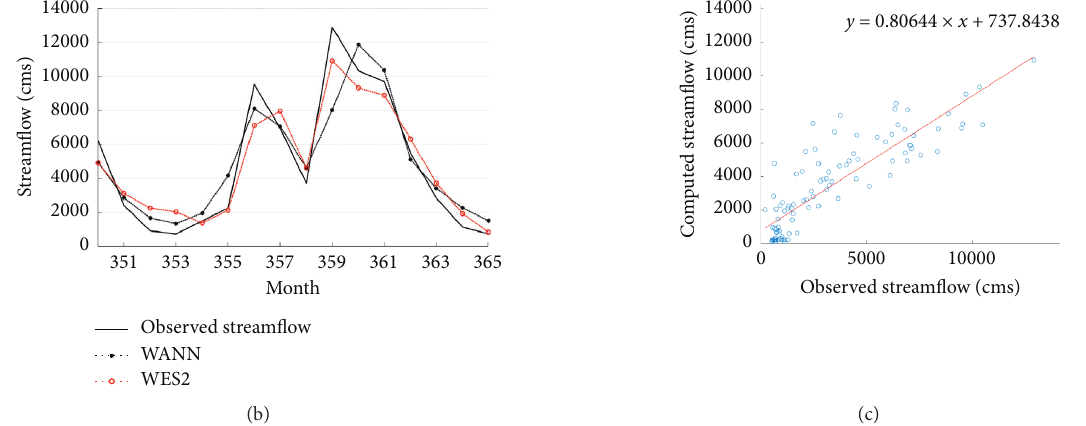
Figure 7: Observed/simulated monthly streamflow of Trinity. (a) Whole. (b) Detail. (c) Verification scatter plot of WES